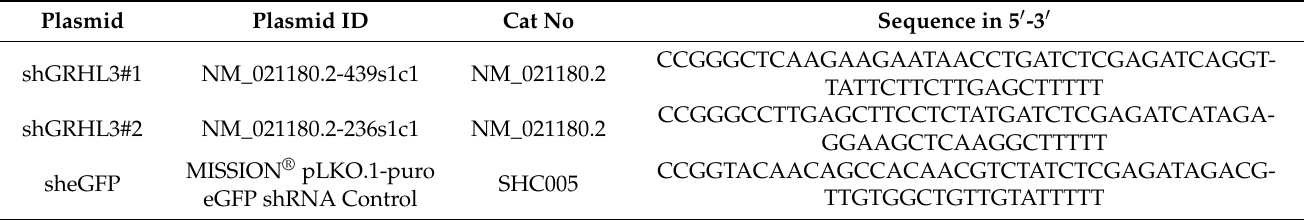
Table 1. Mission ® pLKO.1-puro anti-GRHL3